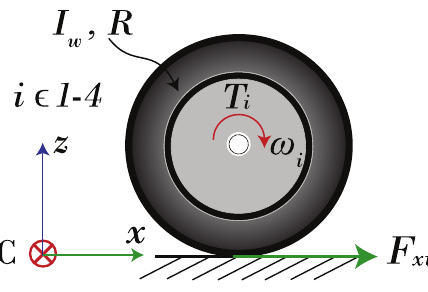
Fig. 14. Wheel angular